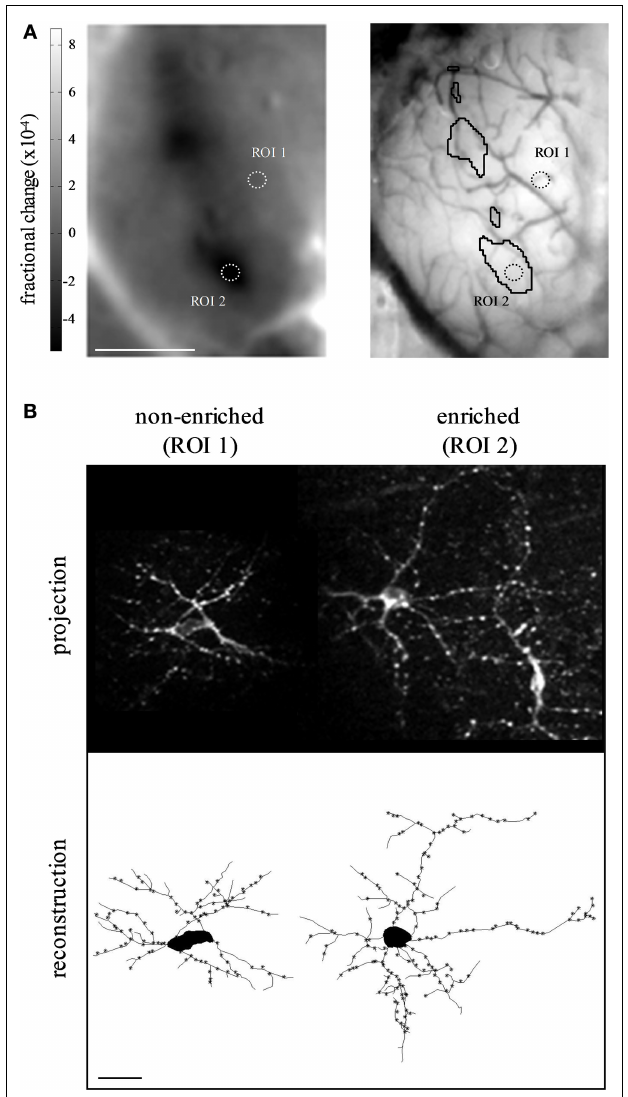
FIGURE 3 | Specifi city of experience-dependent plasticity during adult- born neuron development. (A) Intrinsic signal odor map in response to a two-odor mixture (left panel), and the corresponding blood vessel map on the surface of the olfactory bulb (right panel). Sensory-active domains are marked by a black contour in the blood vessel map. Two regions of interest (ROIs), containing the neurons shown in B, are indicated by dotted circles. ROI 1 is in a sensory-non-active domain, while ROI 2 is within a sensory-active domain. Scale bar: 1 mm. (B) Two adult-born periglomerular neurons expressing PSD95-GFP as a proxy for synapses from the same experiment shown in A. Left: a periglomerular neuron from a non-enriched domain (non-active, ROI 1), Right: a periglomerular neuron from an enriched domain (active, ROI 2). Top, maximum projection images of the original Z stacks. Bottom, two-dimensional view of the reconstructed neurons at the top. Asterisks mark putative synapses. Scale bar: 20 µm. Sensory enrichment increased both the size of the neurons’ dendritic tree and the number of their putative synapses. Adapted from Livneh et al. (2009), with